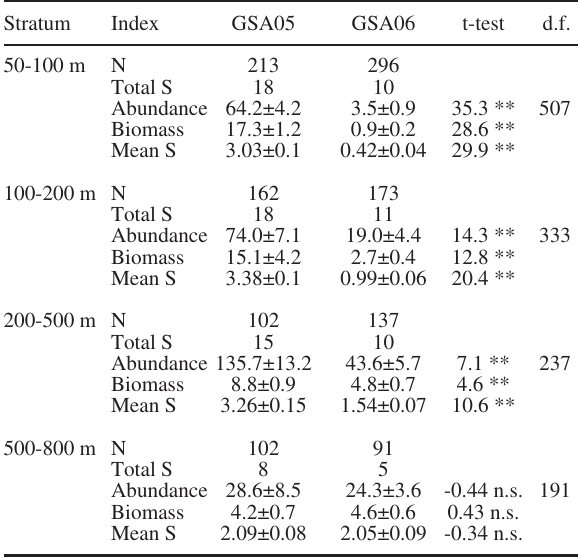
Fig . 6. – Population structure of European hake ( Merluccius merluccius ) in the geographical sub-areas (GSAs) Balearic Islands (GSA05) and Northern Spain (GSA06) obtained from scientific surveys Table 3. – Information on elasmobranch assemblages in four dif- ferent depth strata obtained from MEDITS carried out during 2001- 2010 in the GFCM geographical sub-areas (GSAs) Balearic Islands (GSA05) and Northern Spain (GSA06). Total number of hauls ana- lyzed (N), total species richness (total S), and mean values (± S.E.) of abundance (ind. km -2 ), biomass (kg km -2 ), and species richness (mean S) per haul are shown. Results of the comparison between areas using the Student’s t test are also shown (** significant at P<0.001; n.s. not significant).